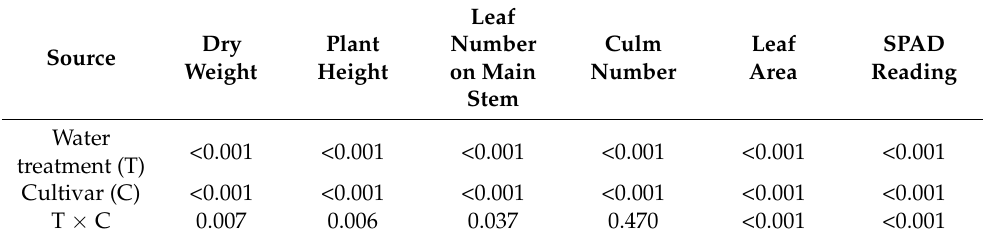
Table 2. ANOVA results ( p -value) of the effect of cultivar and water treatment on agronomic traits.